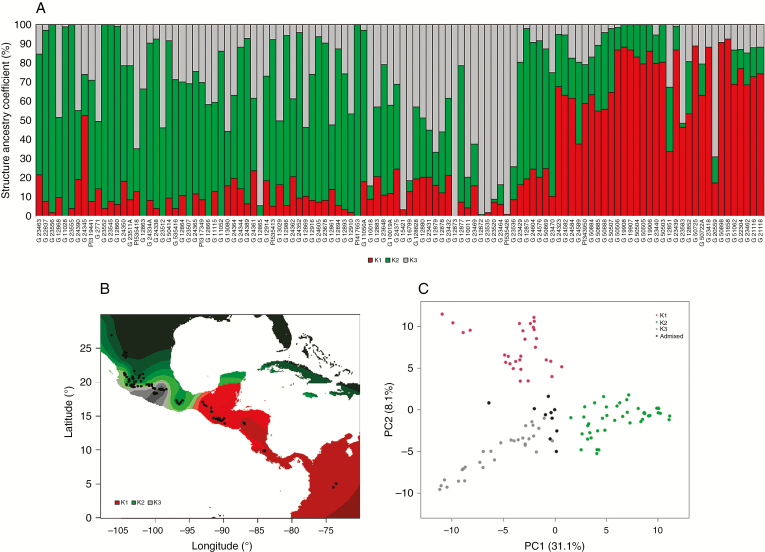
Structure analysis of Mesoamerican wild bean SNP diversity. (A) Barplot of structure ancestry coefficients, sorted by longitude from north to south. (B) Geographical map of ancestry coefficients. (C) Principal components analysis, coloured by structure groups. Accessions with a cluster coefficient cut-off <70 % are coloured as admixed. PC1, PC2, principal components 1 and 2. The percentages in the axis labels represent the eigenvalues of the principal components.